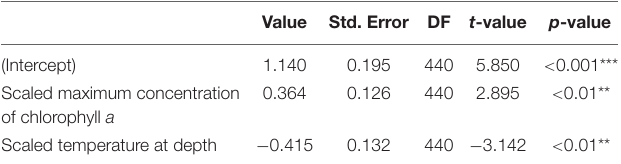
TABLE 2 | Summary of the generalised linear mixed model (GLMM) comparing shark day-time occupancy in shallow water (i.e., TAD above 250 m) in response